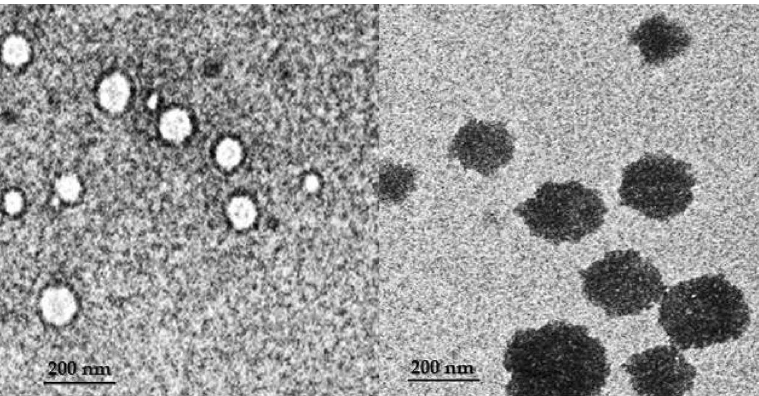
Figure 4. Electron micrograph of PDA stained 24–72 nm diameter of isometric CMV particles (right) and 80–120 nm diameter of quasi spherical tospovirus particles in the infected chilli plant